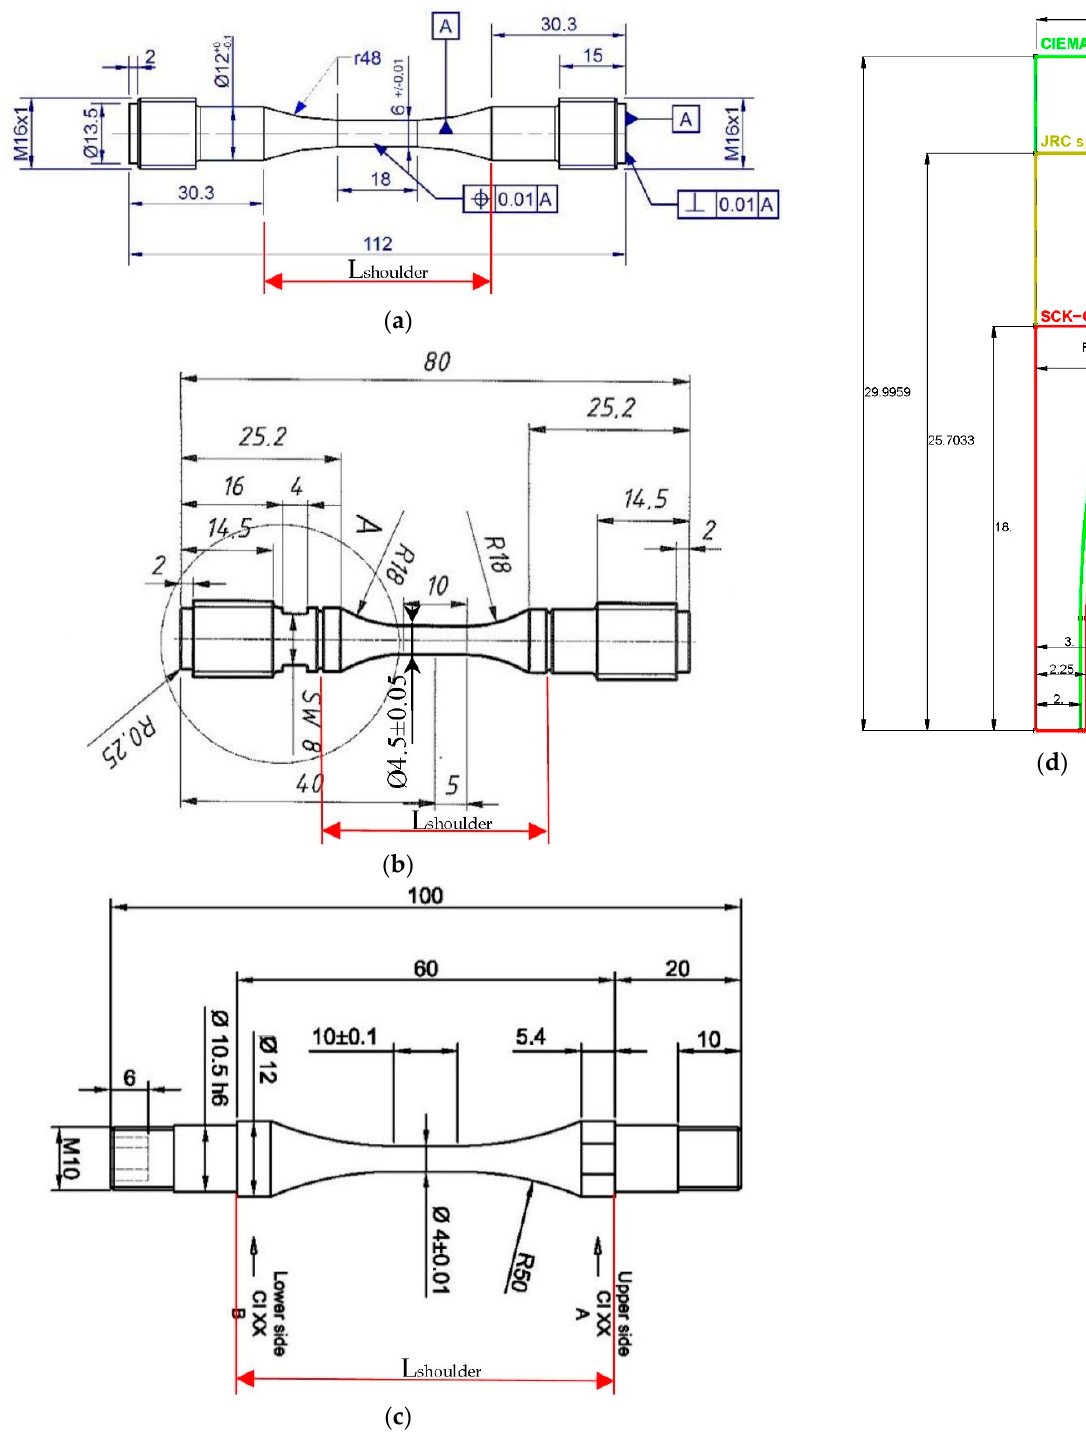
Figure 2. JRC ( a ), SCK-CEN ( b ), CIEMAT ( c ) specimens and geometries of the 2D axisymmetric FEM models ( d ).